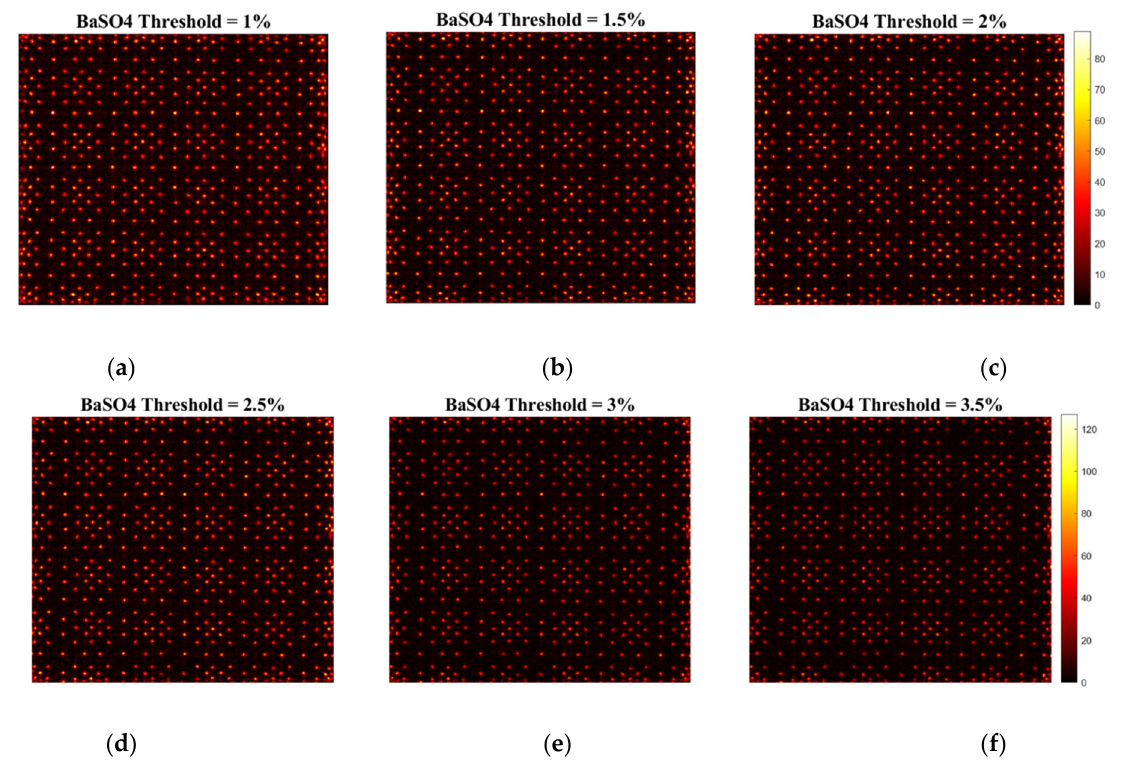
Figure 7. Flood histograms calculated from the experimental data of the dual-layer-offset crystal array constructed with BaSO 4 reflectors: ( a ) threshold = 1%, ( b ) threshold = 1.5%, ( c ) threshold = 2%, ( d ) threshold = 2.5%, ( e ) threshold = 3%, and ( f ) threshold = 3.5%.